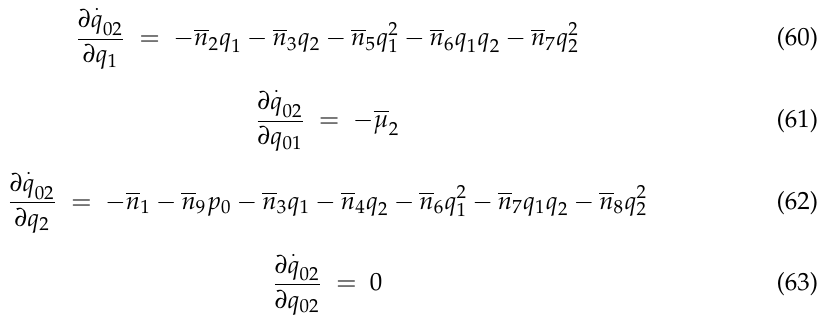
(cid:112) ( 1 − ν 2 ) ρ / E ) for a simply supported